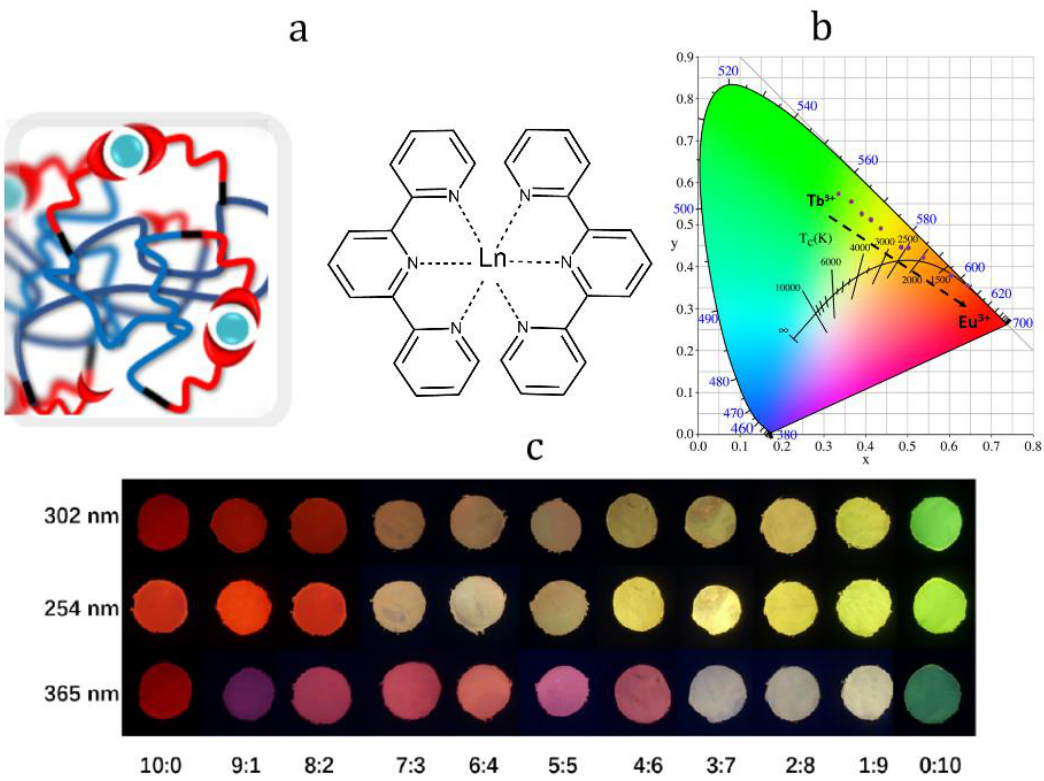
Figure 12. The proposed structure of Ln − Tpy − PDMS5000 ( a ), CIE 1931 color space ( b ), and optical images of Ln-Tpy-PDMS5000 (Ln: Eu and/or Tb) excited under 302, 254 and 365 nm (from right to left: Eu:Tb = 10:0, 9:1, 8:2, 7:3, 6:4, 5:5, 4:6, 3:7, 2:8, 1:9, 0:10) ( c ). Reproduced with permission [75]. Copyright 2022, Elsevier.